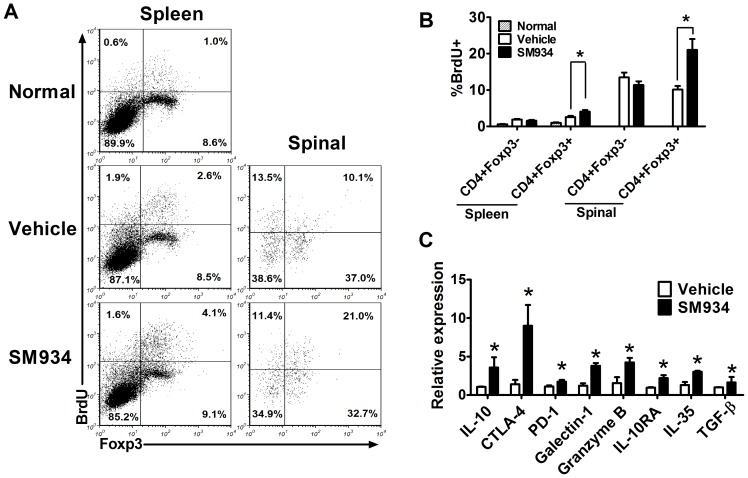
SM934 treatment enhanced Treg cells expansion in EAE mice.(A) Vehicle and SM934 treated mice were given daily i.p. injection of BrdU for 3 days from day 17 p.i., splenocytes and MNC in spinal cord were isolated and analyzed for BrdU incorporation. The proliferative profile was evaluated in CD4+Foxp3−, CD4+Foxp3+ splenocytes, and CD4+Foxp3−, CD4+Foxp3+ from spinal cord. (B) Percentage of CD4+Foxp3−, CD4+Foxp3+ splenocytes, and CD4+Foxp3−, CD4+Foxp3+ from spinal cord are expressed as mean ± SEM (n = 4). (C) CD4+ T cells were purified by immunomagnetic negative selection from splenocytes, indicated genes expression was analyzed by real-time PCR. Results were expressed as mean ± SEM. *, p<0.05 compared with vehicle control. Three independent experiments were performed with similar results.